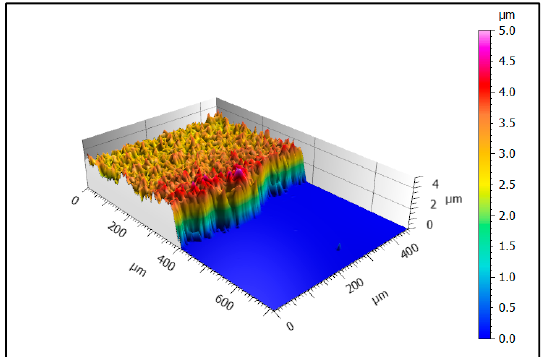
Figure 5. Pseudocolor image of the edge area of sample 1 showing the transition from substrate (blue) to deposited film (yellow/red) at 50× magnification.